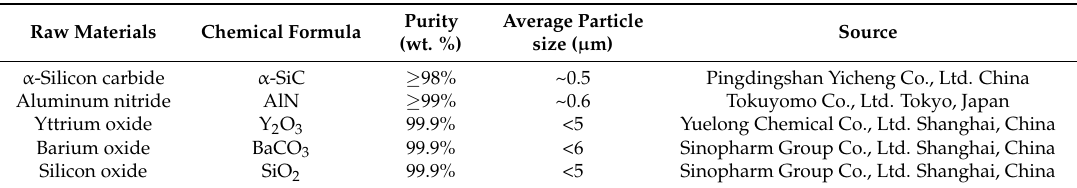
Table 1. Characteristics of the raw